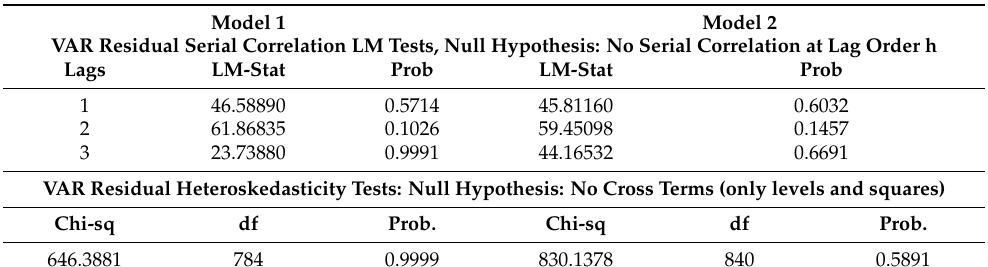
Table 7. Residual